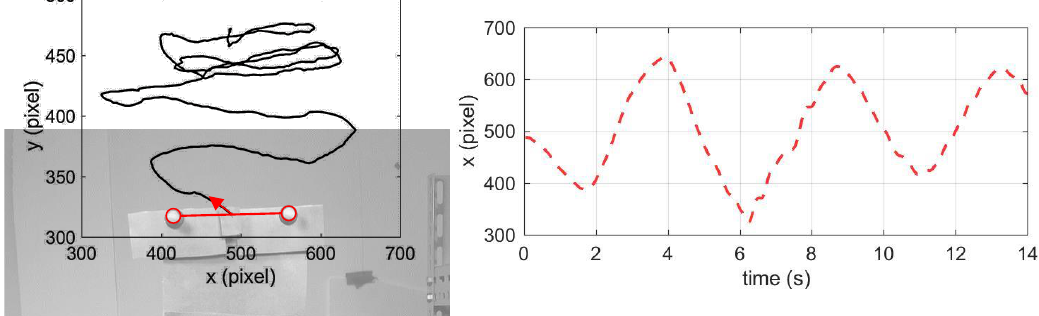
Figure 13. Trajectory of the markers in the second story before image rectification.